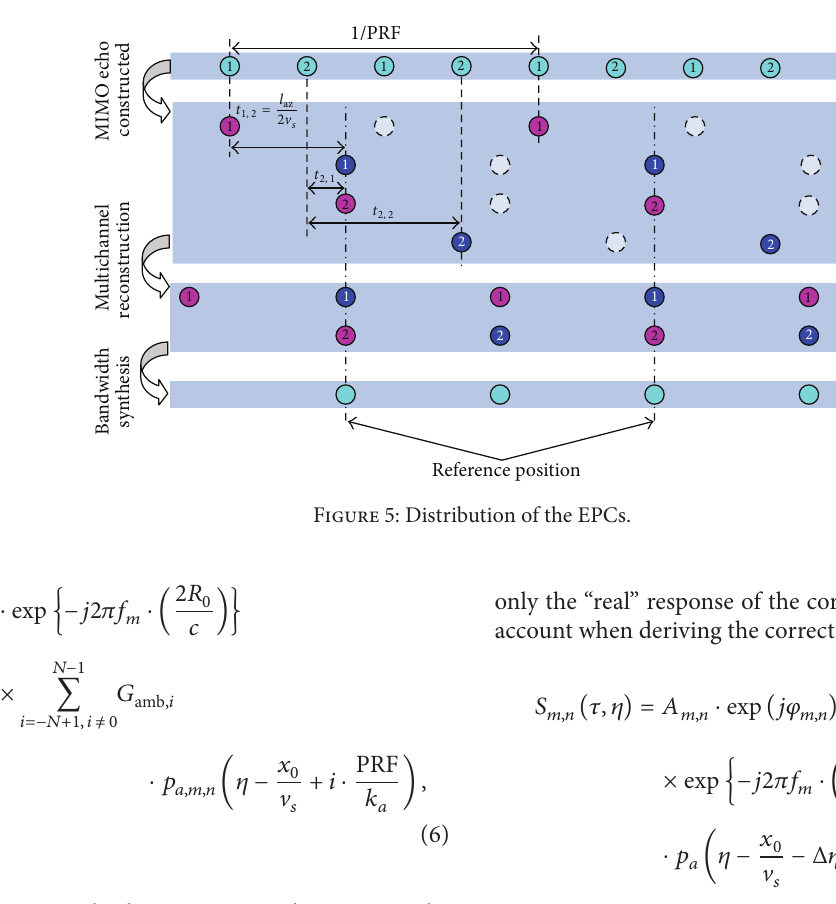
Figure 4: Block diagram of the image formation processing.